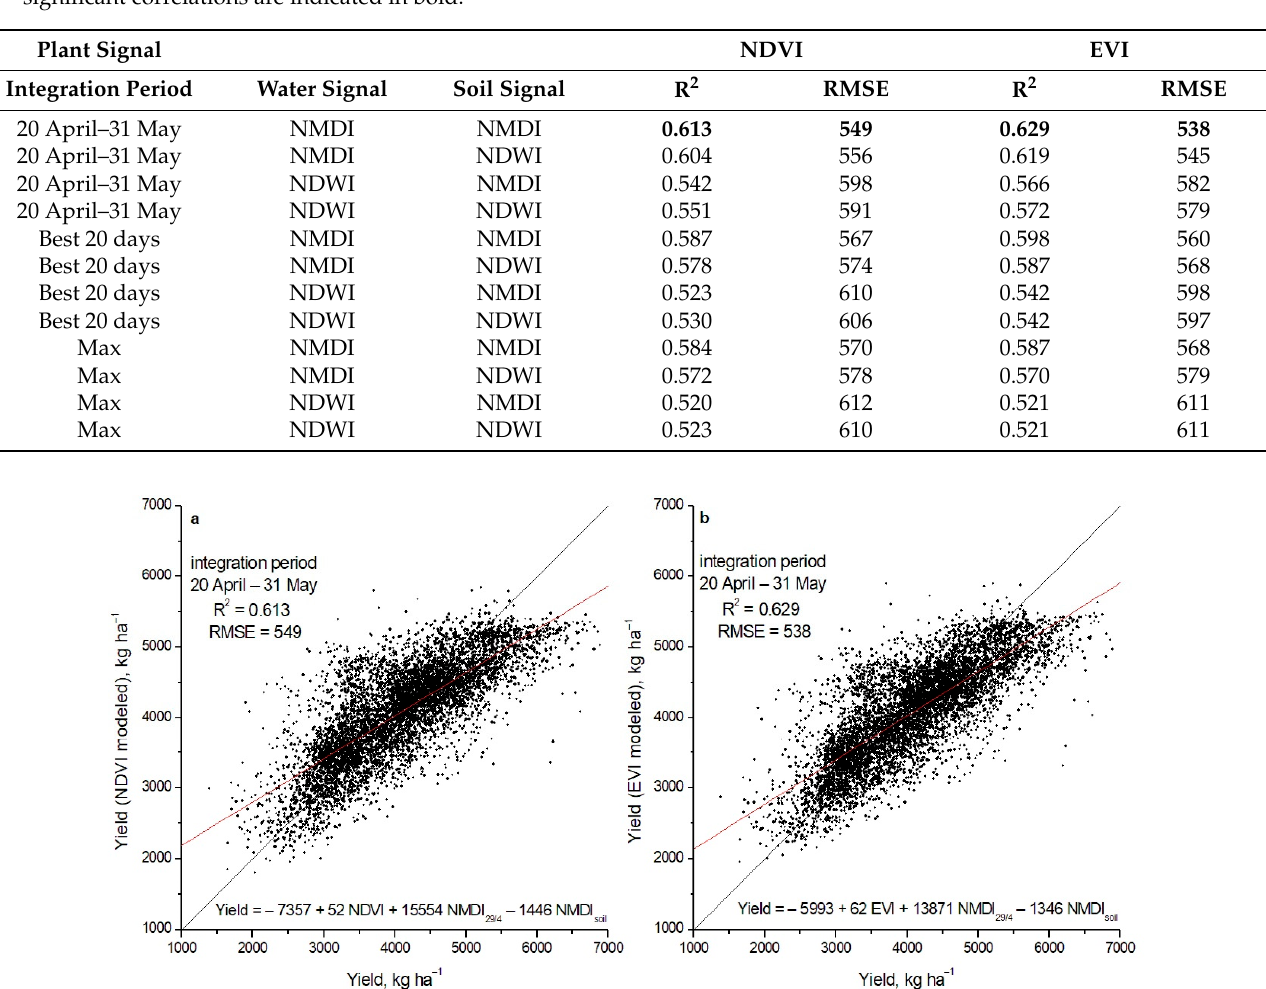
Table 4. Coefficients of determination (R 2 ) and root mean square error (RMSE, kg ha − 1 ) between measured final yield and various model versions incorporating different plant, water, and soil signals. Best 20 days integral concerns the 13 April–2 May period. Data concern 31 fields during two growing periods, corresponding to 7436 pixels. The most significant correlations are indicated in bold.